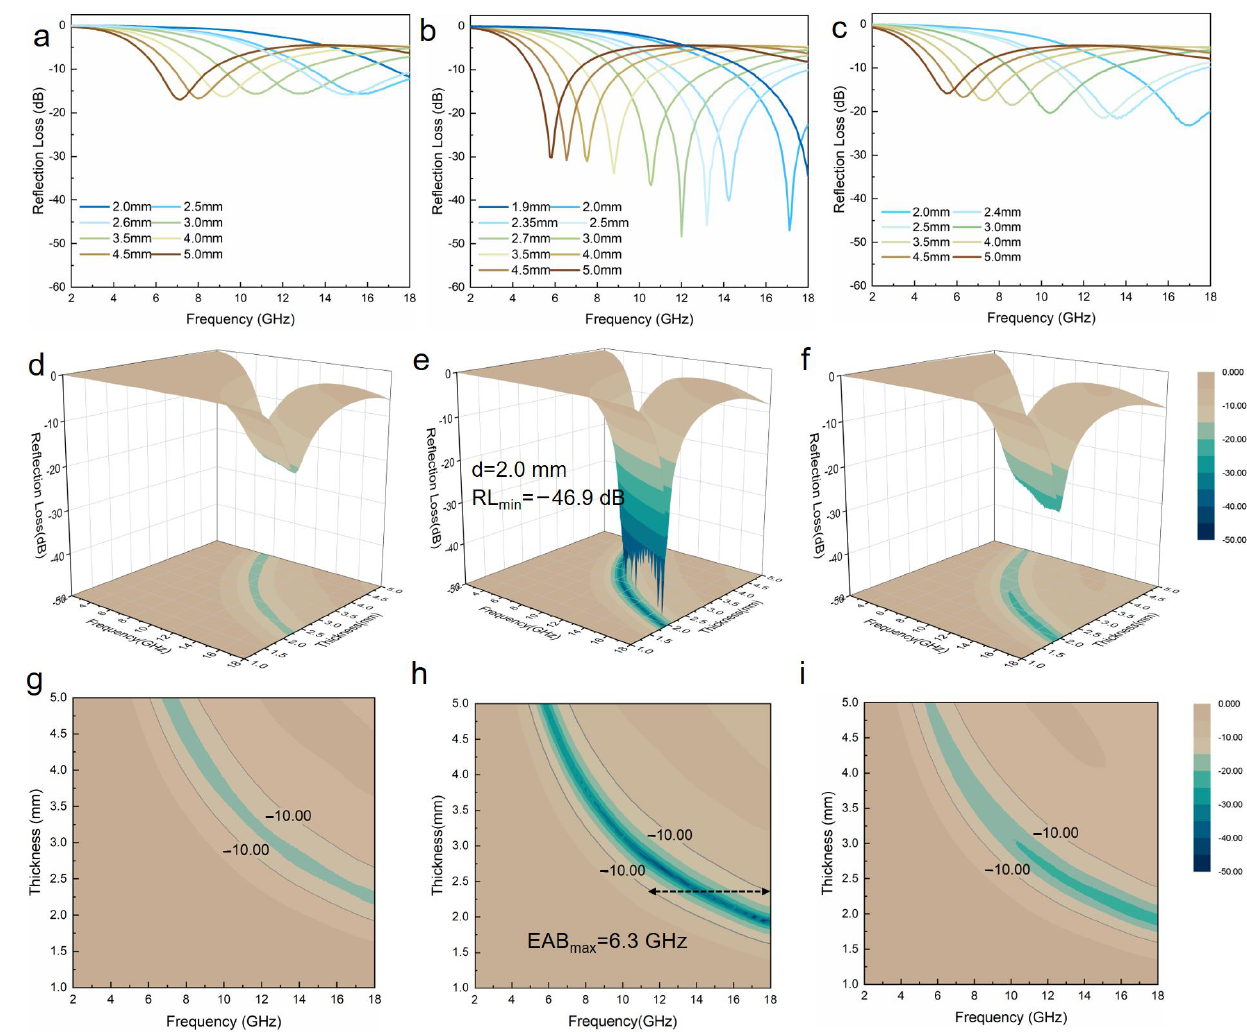
Figure 5. ( a – c ) Reflection loss (RL) curves, ( d – f ) 3D and ( g – i ) 2D representations of the RL for Ni 3 S 2 @NSGAs pyrolyzed at different Table 1. Comparison of EM absorption performance between Ni 3 S 2 @NSGA-650 and the reported Ni 3 S 2 -based materials.